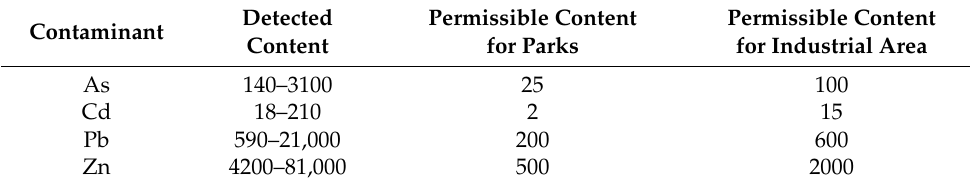
Table 1. Contamination level at Antonia Hill (mg/kg) [60,80].